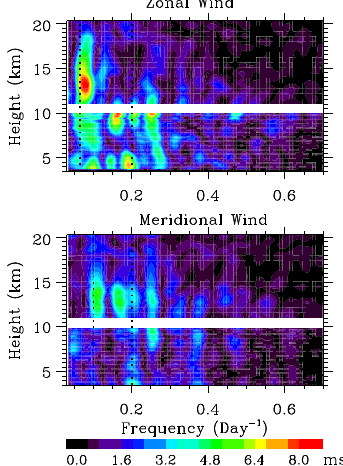
Figure 8. The same as Fig. 3 except that the displaying period range is from 1.5 to 30 days. The maximum spectral magnitudes for the zonal and meridional winds are 8.74 and 5.72ms − 1 , respectively. The vertical dotted lines denote the exact 16-day and 5-day periods in the zonal wind and the exact 10-day and 5-day periods in the meridional